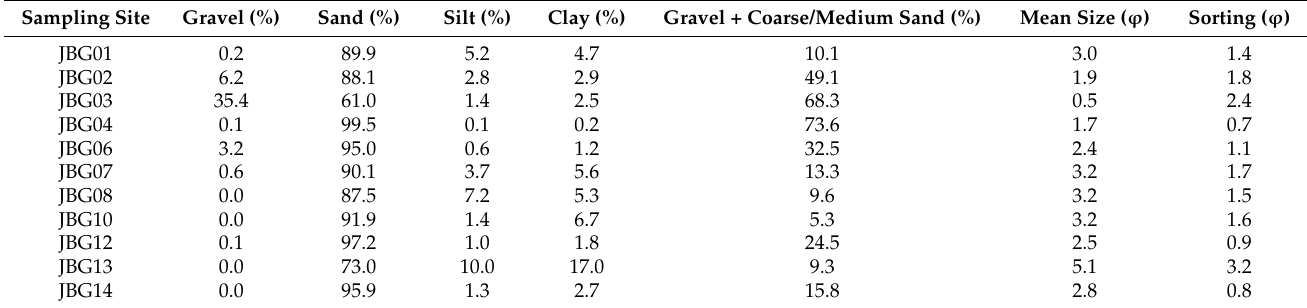
Table 2. Grain size distribution of surface sediments collected from Terra Nova Bay, Ross Sea,